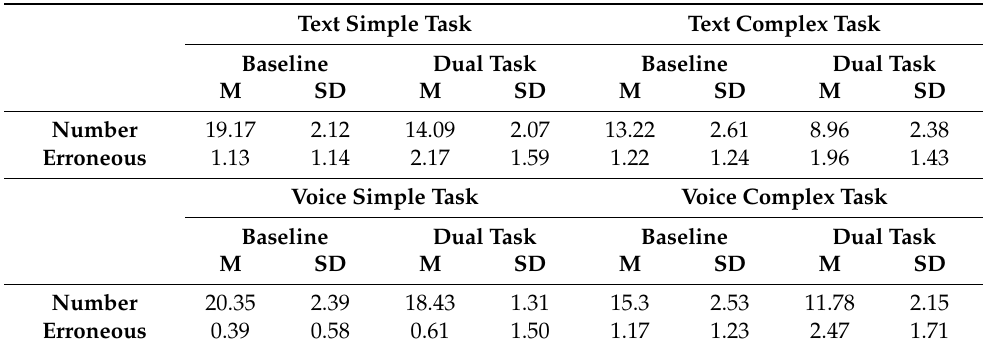
Table 2. Means and standard deviations of the number of answers and number of erroneous answers sent by participants in the baseline and dual-task